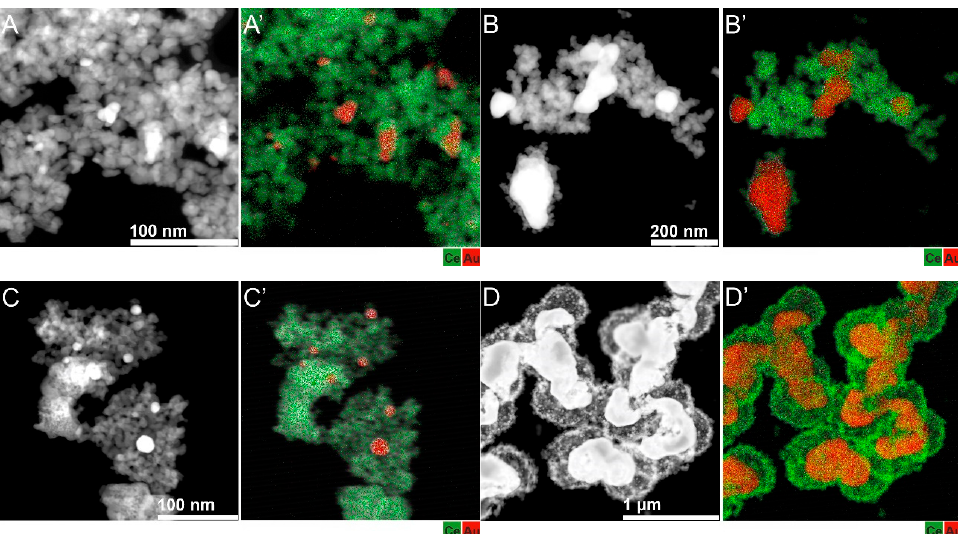
Figure 5. High angle annular dark field STEM (HAADF STEM) image and EDS elemental map of Au-CeO 2 _N ( A , A’ ), Au-CeO 2 _H ( B , B’ ) and Au-CeO 2 _U ( C , C’ , D , D’ ).